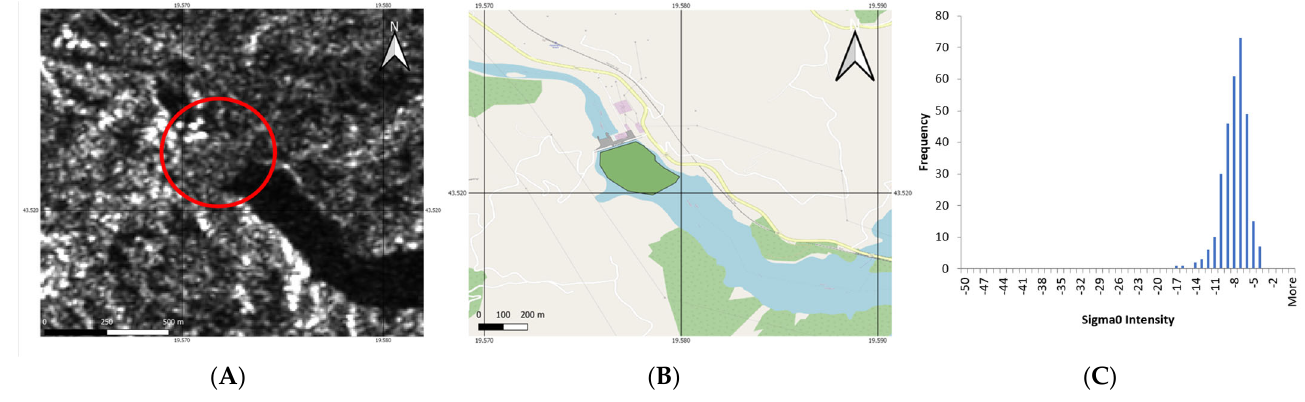
Figure 4. Image from 6 January 2021, in Sentinel-1 VV channel showing plastic accumulation near Potpecko Lake hydroelectric dam, Serbia. ( A ) VV Intensity with red marker highlighting dam and accumulation, ( B ) Polygon used for histogram, and ( C ) Histogram of pixels in polygon (Sentinel-1, Credits: